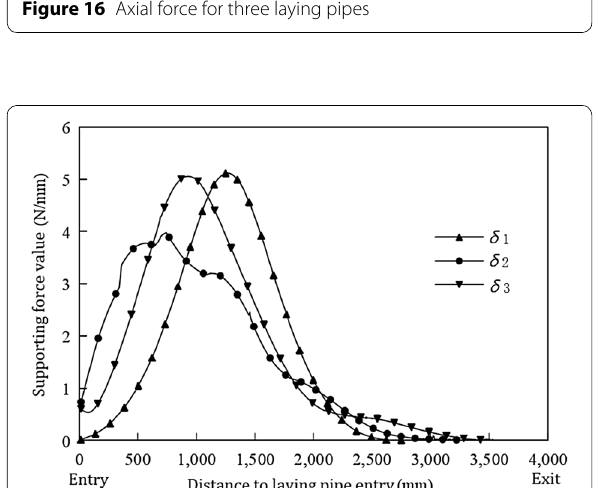
Figure 17 Supporting force for three laying pipes